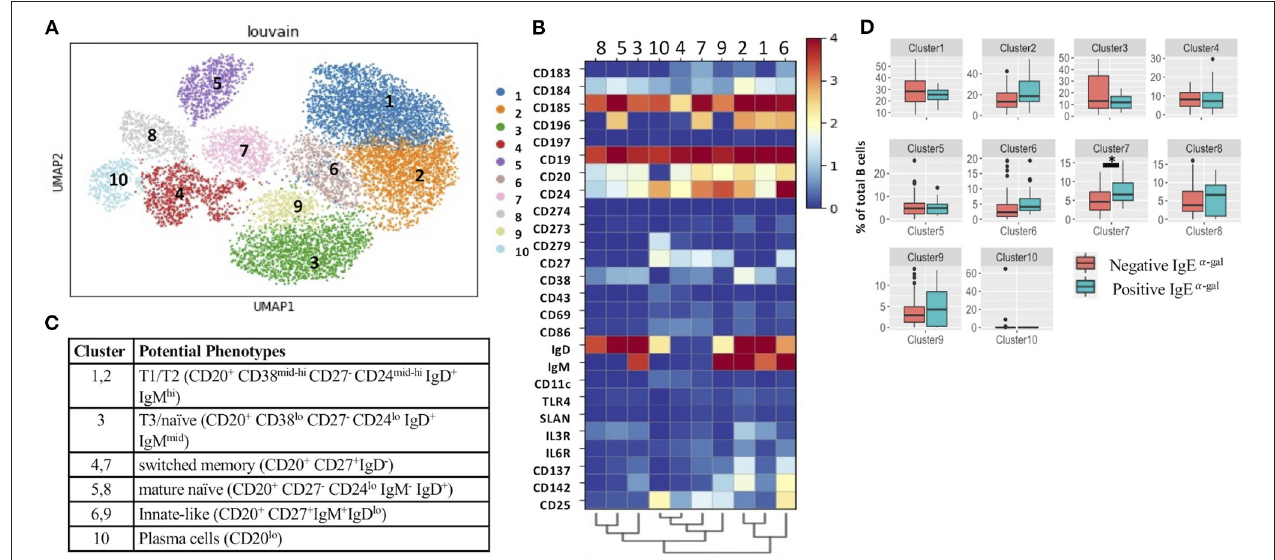
FIGURE 1 | Single cell multi-omics platform identified an association between circulating CCR6 + switched memory B cells and α -gal sensitization. (A) Representative metacluster UMAP showing 10 distinguished B cell subsets by using Louvain clustering. (B,C) Heatmap showing median expression of surface markers from metaclustering (B) , table showing potential phenotypes of each B cell subset resulting from Louvain clustering (C) . (D) Biaxial plots to compare frequency of each cluster as a percentage of total B cells in subjects with and without α -gal sensitization. * p < 0.05 by Mann-Whitney